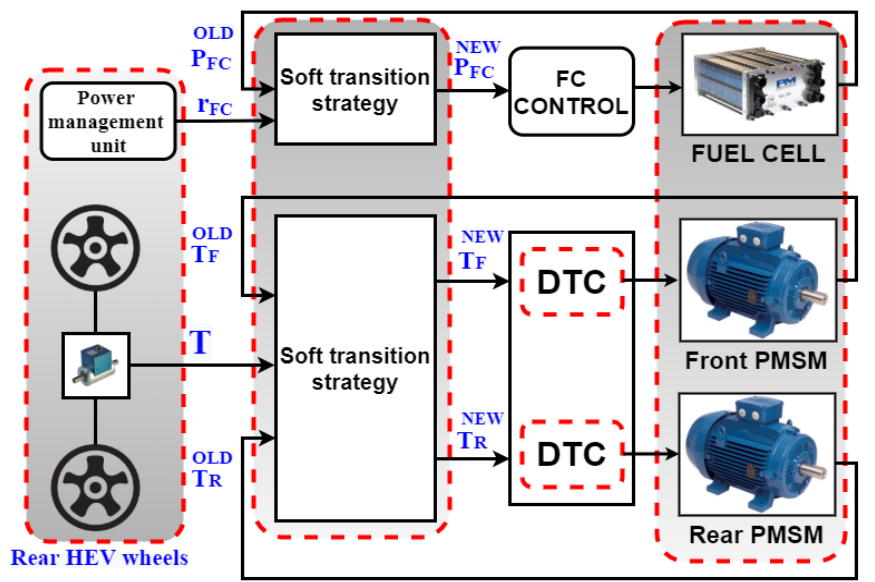
Figure 12. Proposed HEV based STA scheme.